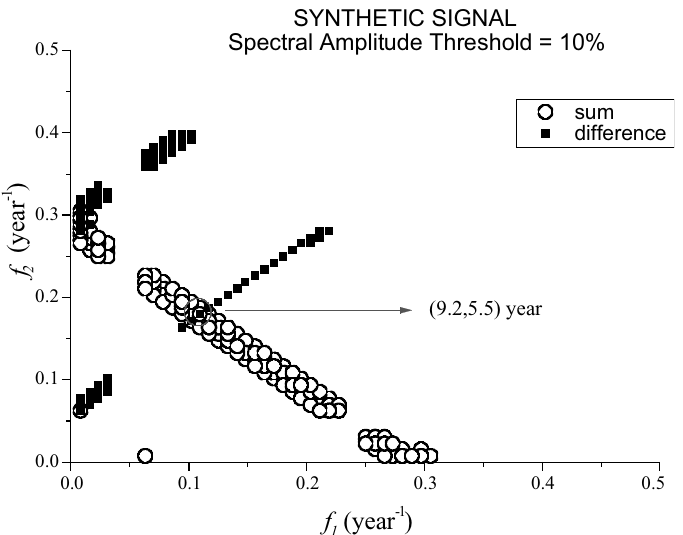
Fig. 4. The method of SPAQCE applied to a short synthetic signal composed of 128 data and consisting of a product of two sines with periods of 5.5 and 8.5 years respectively. This figure evidences the quadratic phase coupling in terms of overlapping between black squares (representing couplings in the differences of couples of frequencies) and white circles (representing couplings in the sums of couples of frequencies). This diagram is based on the largest 10% spectral